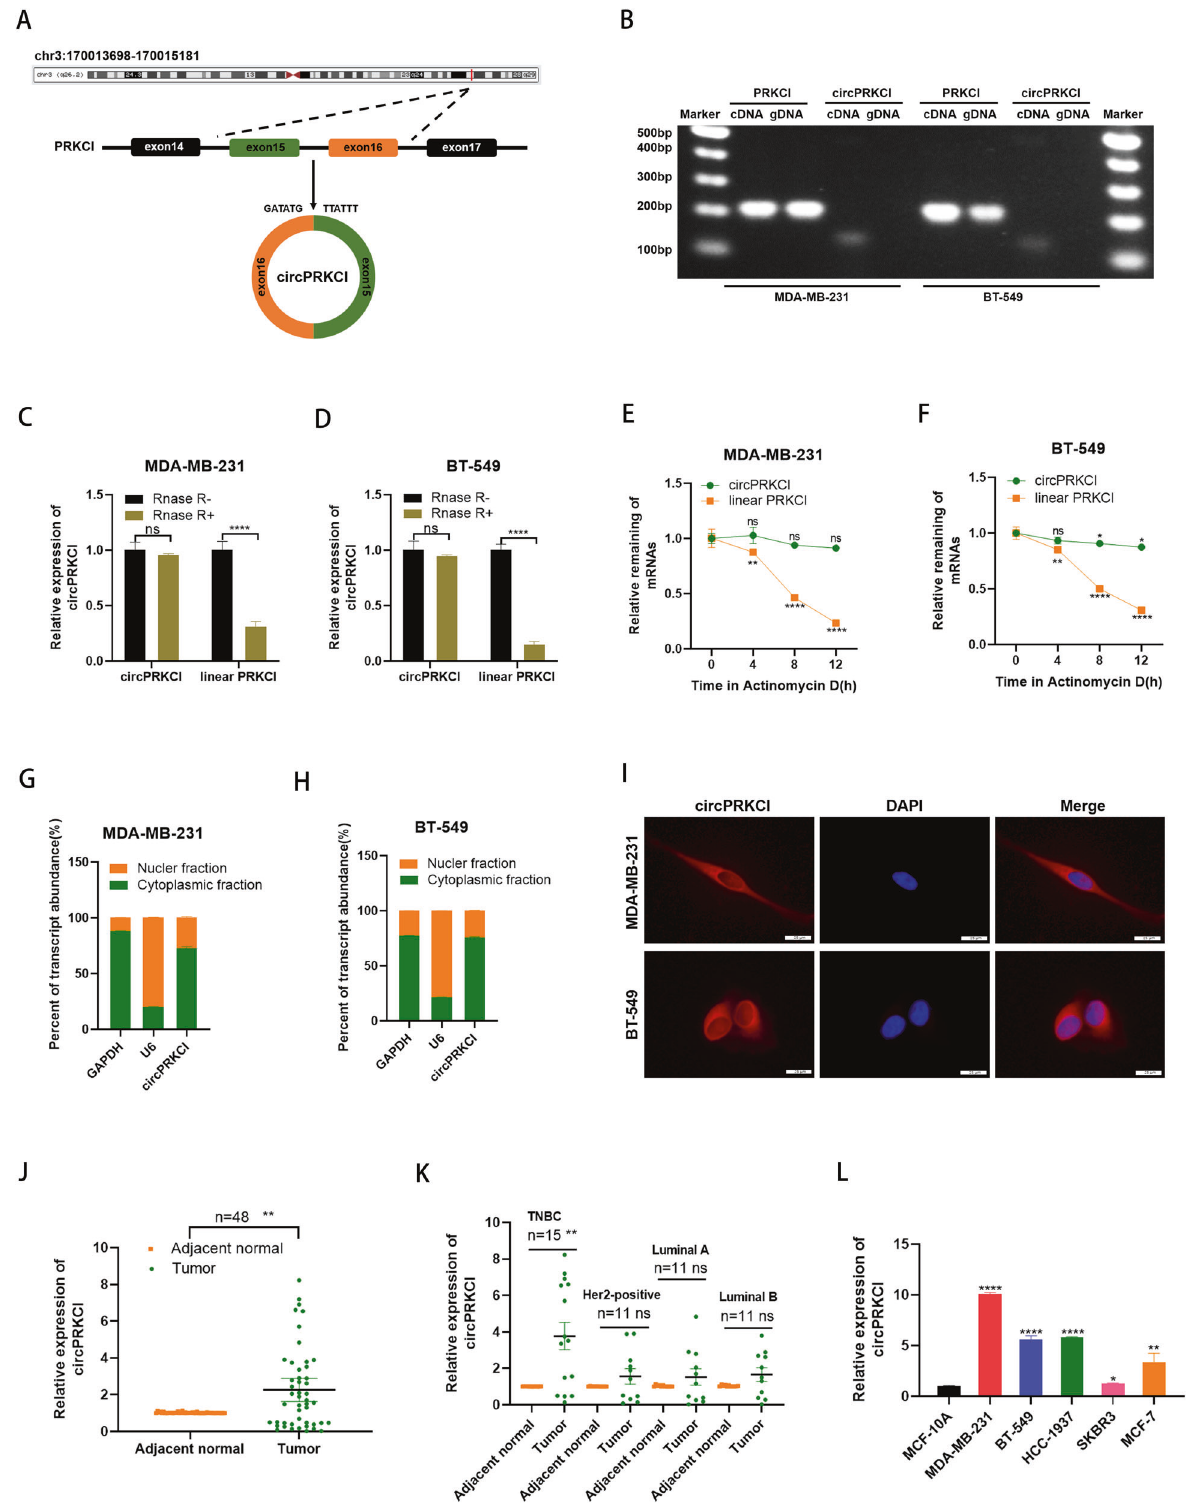
Fig. 1 Characteristics of circPRKCI in TNBC cells. A CircPRKCI is formed by circularization of exon 15-16 of the gene PRKCI. B Existence of circPRKCI in TNBC cells was veri fi ed by agarose gel electrophoresis. C , D qRT-PCR analysis of circPRKCI and linear PRKCI in TNBC cells treated with RNase R. E , F After Actinomycin D treatment, the mRNA stability of circPRKCI and PRKCI in TNBC cells was determined by qRT-PCR. G , H Expression levels of cytoplasmic control transcripts (GAPDH), the nuclear control transcript (U6), and circPRKCI were determined by qRT-PCR in the cytoplasmic and nuclear fractions of TNBC cells. I RNA FISH for circPRKCI and nuclei was stained with DAPI. Red, circPRKCI; Blue, DAPI. J CircPRKCI was highly expressed in tumor tissues compared with adjacent normal tissues. K Expression of circPRKCI in TNBC cohort, Her2- positive cohort, luminal-A and luminal-B cohort, respectively. L Relative expression of circPRKCI in BC cell lines. * p < 0.05, ** p < 0.01,**** p < 0.0001. Cell Death Discovery (2022)